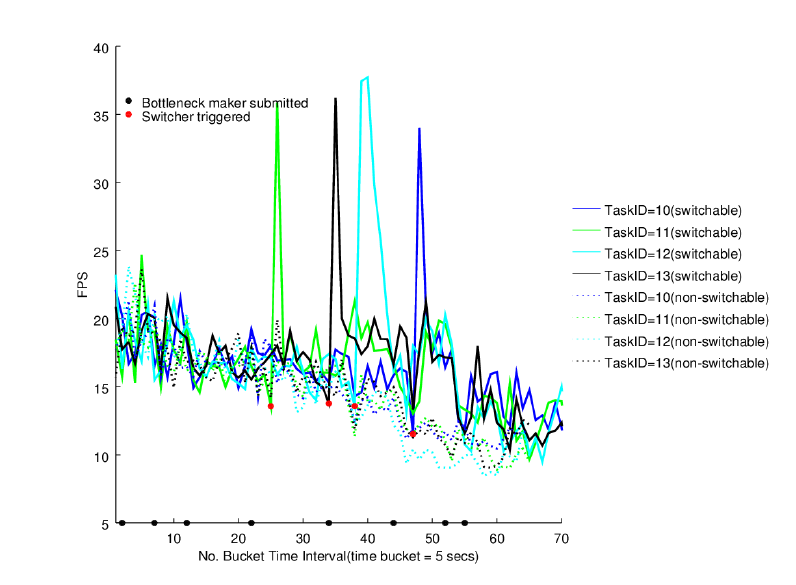
Figure 12. Switcher performance under the CPU-intensive bottleneck maker.